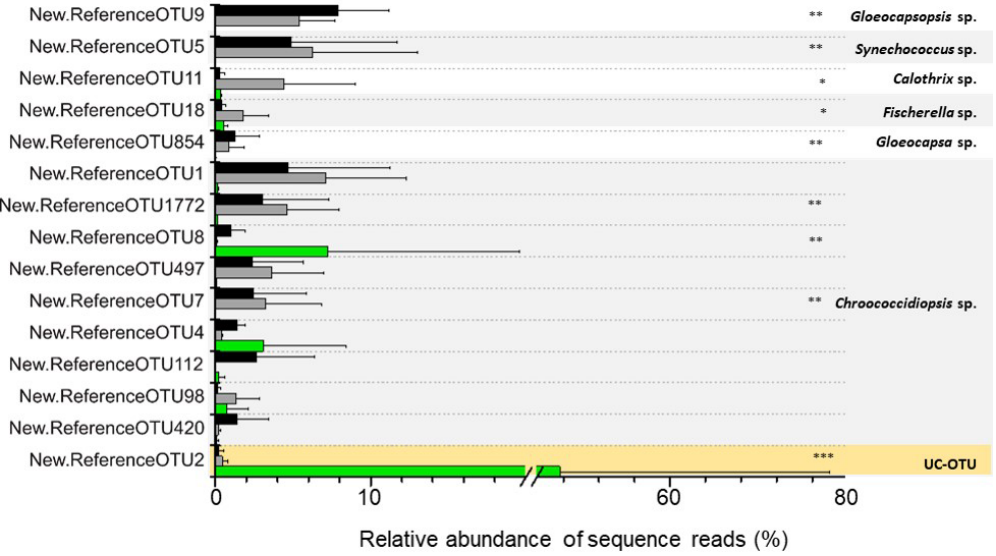
Figure 6. Differentially abundant cyanobacterial OTUs across the three microhabitats are represented by ∗ (Diff-OTUs, p value < 0.01CH / CR-HE), ∗∗ (Diff-OTUs, p value < 0.001HE / CR-CH) and ∗∗∗ (Diff-OTUs, p value < 0.0001HE / CR-CH). UC-OTU repre- sents unclassified cyanobacterial OTU. Only sequences > 1% relative abundances were used. In the figure, black bars represent CR, grey bars represent CH and green bars represent